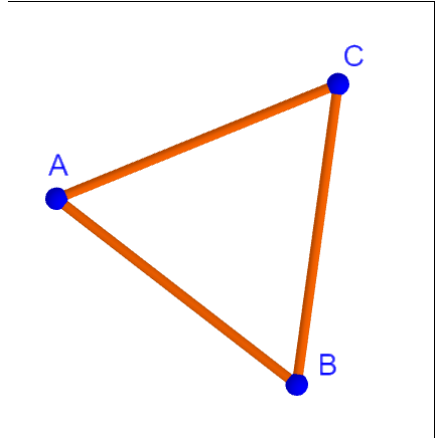
Figure 3. A triangular free linkage in the